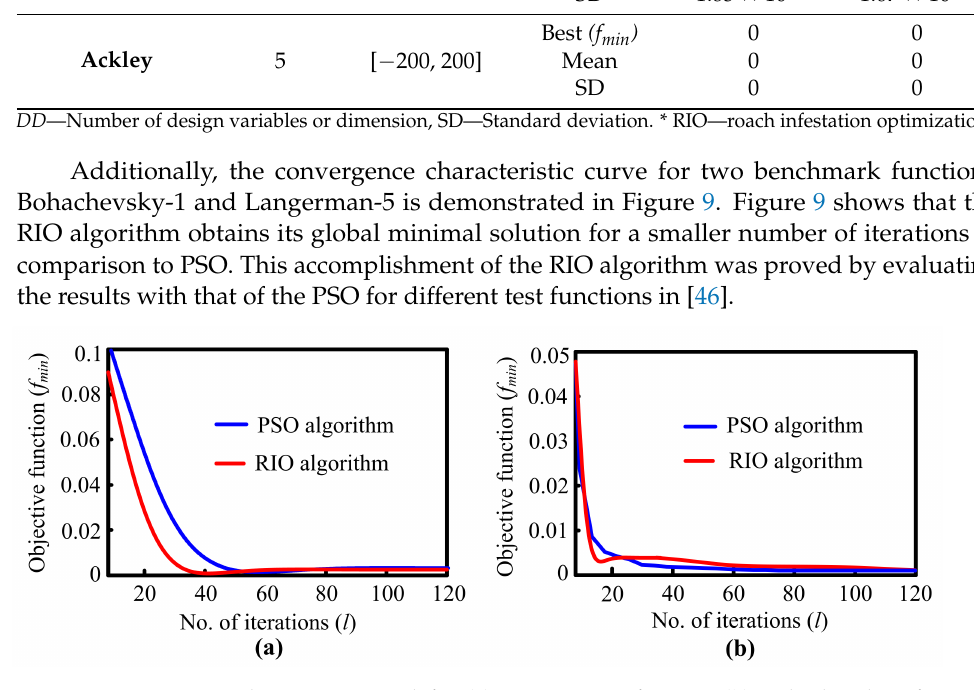
Figure 9. Convergence characteristic graph for: ( a ). Langerman-5 function, ( b ). Bohachevsky-1